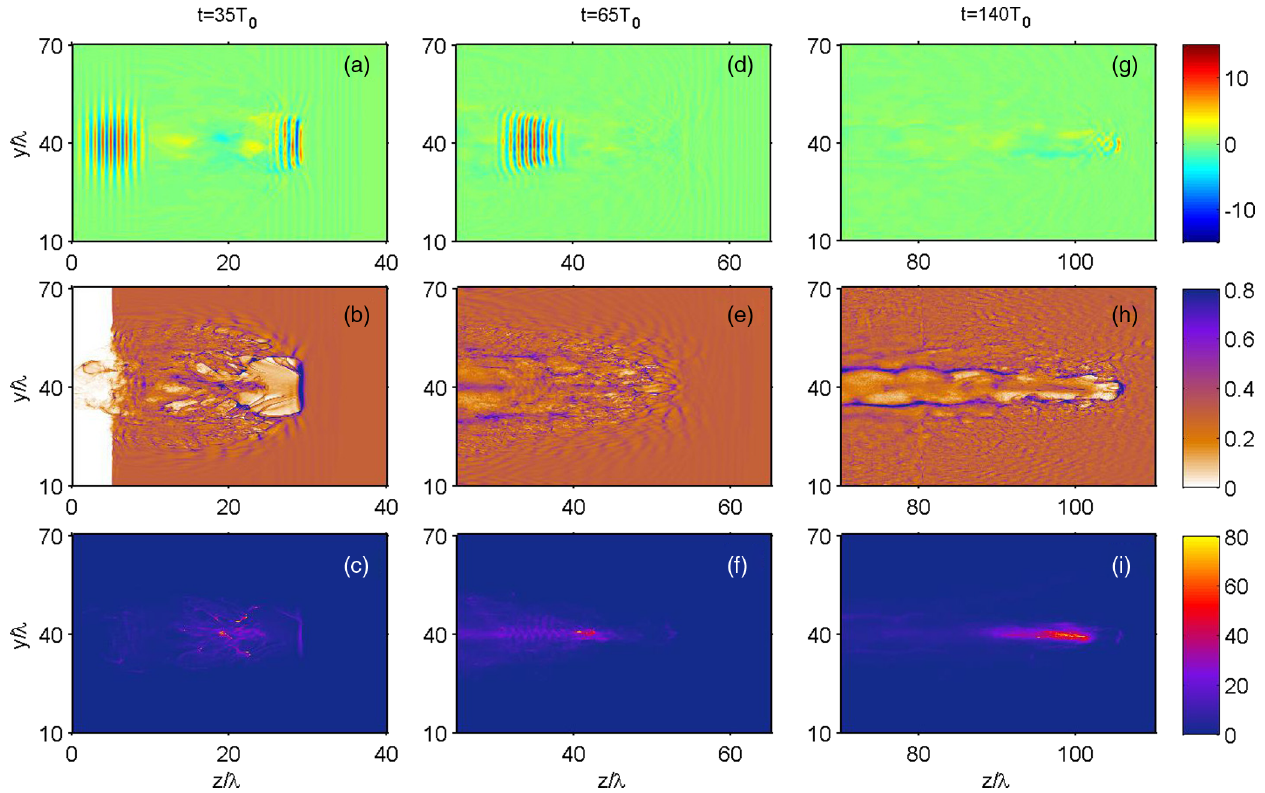
FIG. 2. Evolution of the laser-plasma system at t ¼ 35 T 0 , 65 T 0 , and 140 T 0 (left to right columns). The laser propagates in the z direction. (a), (d), and (g) Laser electric field normalized by m e ω c=e , where ω is the laser frequency, and m e and e are the electron mass and charge. (b), (e), and (h) Electron density normalized by n c . (c), (f), and (i) Electron energy density normalized by n c m e c 2 . The laser strength parameter a L is 10, the spot radius b is 10 λ , and the duration τ is 5 T 0 . The distance between the two laser pulses is 25 λ . The plasma density is n e ¼ 0 . 3 n c